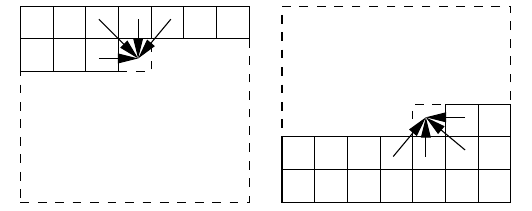
Figure 2: Calculation of the eight path directions in a top-down pass (left) and a bottom-up pass